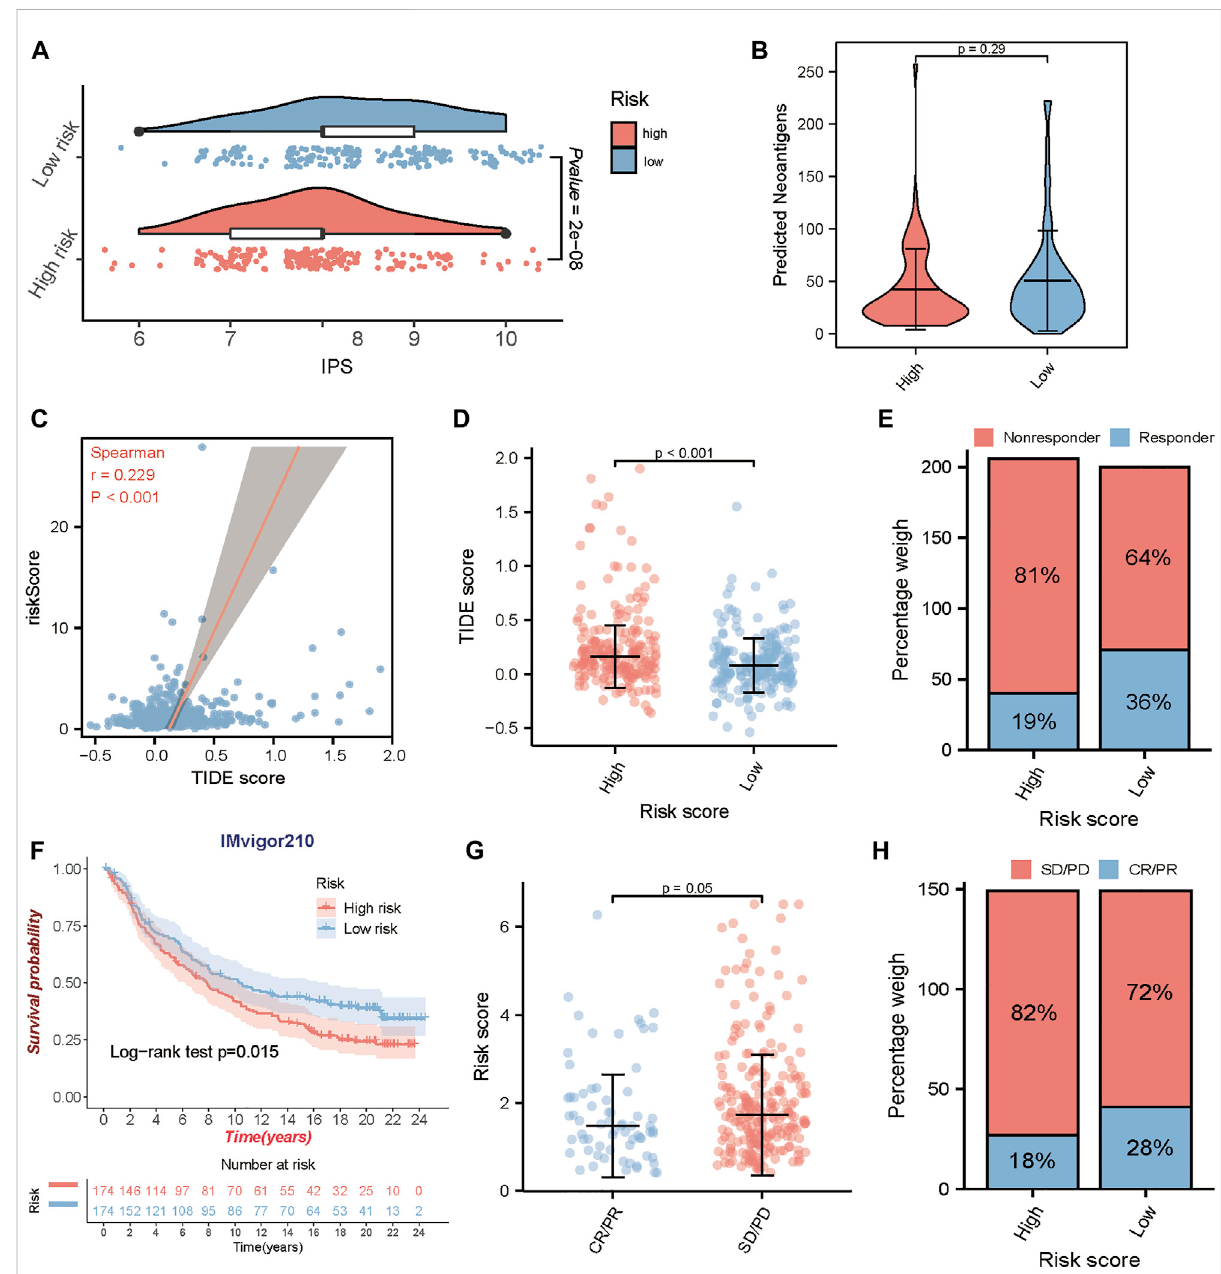
FIGURE 7 Prediction of immunotherapeutic bene fi ts using the risk score. In TCGA-BLCA cohort, (A) the relative distribution of the immunophenoscore (IPS) between the high and low-risk groups. (B) The difference of the predicted neoantigens in the high and low-risk groups. (C, D) The correlation analysisbetweenriskscoreandTIDEscore,andthecomparisonoftheTIDEscoreinthehighandlow-riskgroups. (E) Theproportionofpatientswith response to immunotherapy inhigh orlow-riskgroups. In IMvigor210 cohort, (F) Kaplan-Meier survival curves for high and low-risk groups. (G) The comparison of the risk score between mUC patients with different clinical responses (CR/PR and SD/PD). (H) The proportion of patients with clinical response to anti-PD-L1 immunotherapy in high or low-risk groups. CR, complete response; PR, partial response; SD, stable disease; PD, progressive